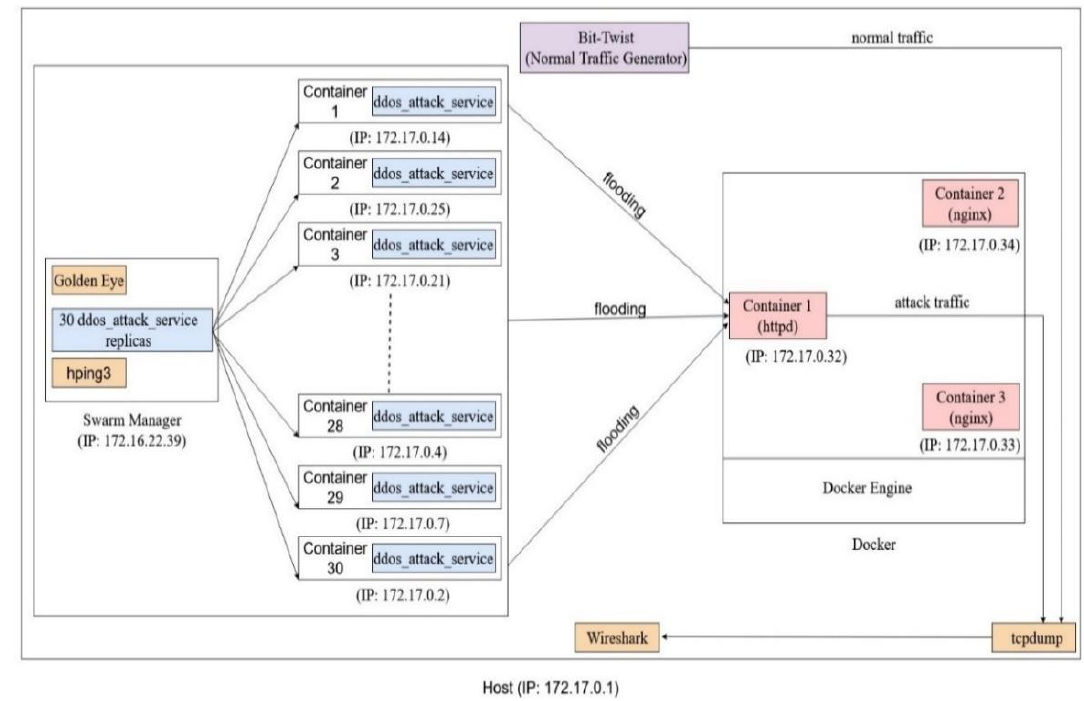
Figure 3. The testbed environment for DDoS